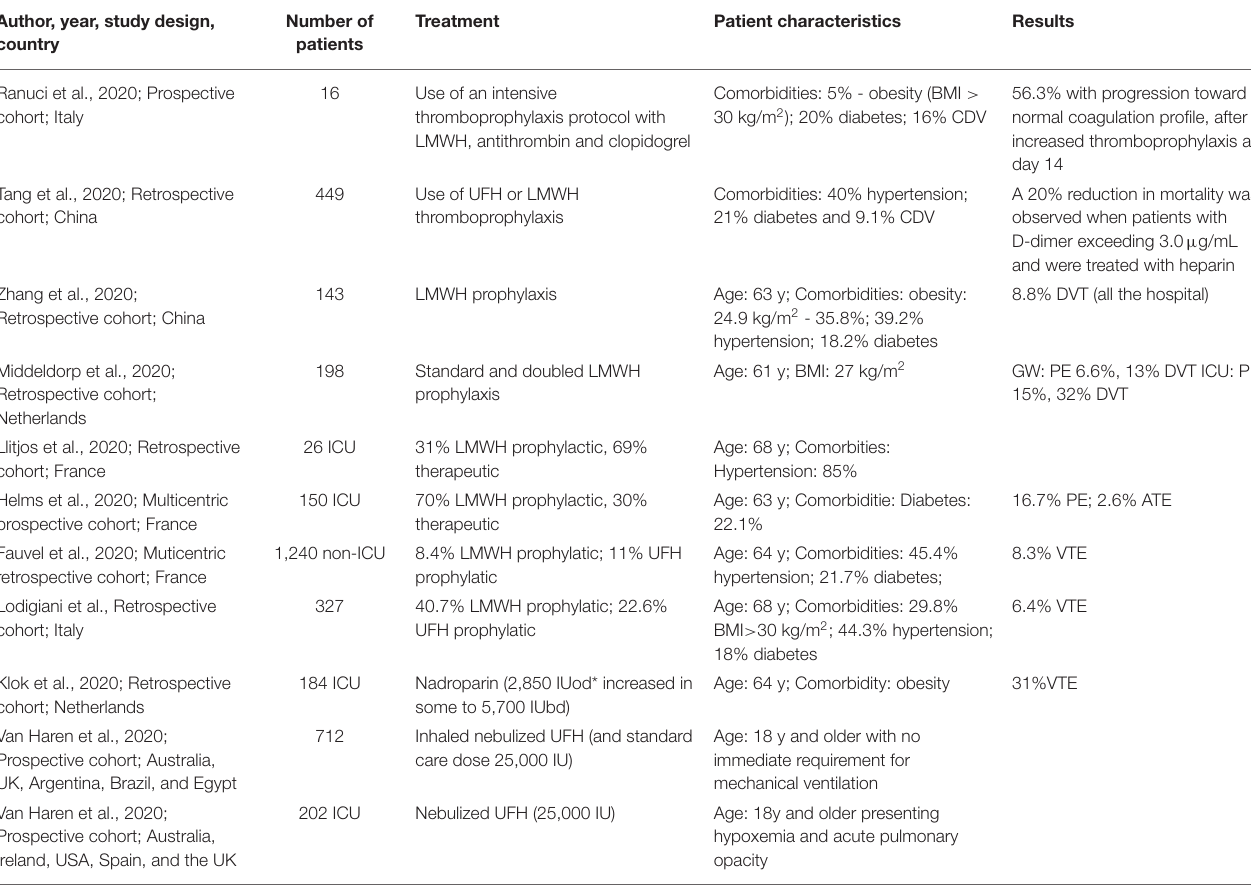
TABLE 1 | Studies on heparin therapy for